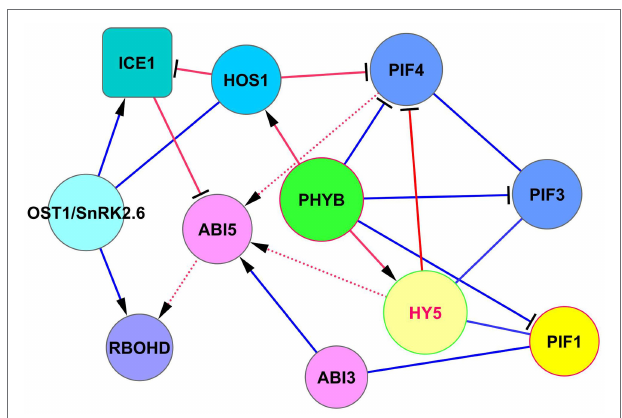
FIGURE 5 | The intersection of ICE1 and HY5 functions in cold adaptation. ABI5 serves as a concentrator of ICE1, PIF4, and HY5 signaling. ABI5 receives signals from these proteins to regulate RbohD expression and H 2 O 2 level to establish cold protection. Note, that HY5 does not physically interact with PIF4 (BioGRID) but regulates its function through competitive chromatin binding to PIF4 targets (Gangappa and Kumar, 2017). ICE1 physically associates with ABI5 and antagonizes its transcriptional function by concurring with G-box type cis elements in promoters of responsive genes (Hu et al., 2019). Abbreviations: ICE1, inducer of CBP expression 1; HOS1, E3 ubiquitin-protein ligase HOS1; ABI3/5, ABA insensitive 3/5; OST1/ SnRK2.6, SNF1-related protein kinase 2.6; PIFs, phytochrome-interacting transcription factors; PHYB, phytochrome phyB; HY5, transcription factor HY5. RBOHD, respiratory burst oxidase homolog protein D (NADPH oxidase RbohD). FIGURE 6 | Regulation of CBF/DREB1 pathway by ABA and light signaling.